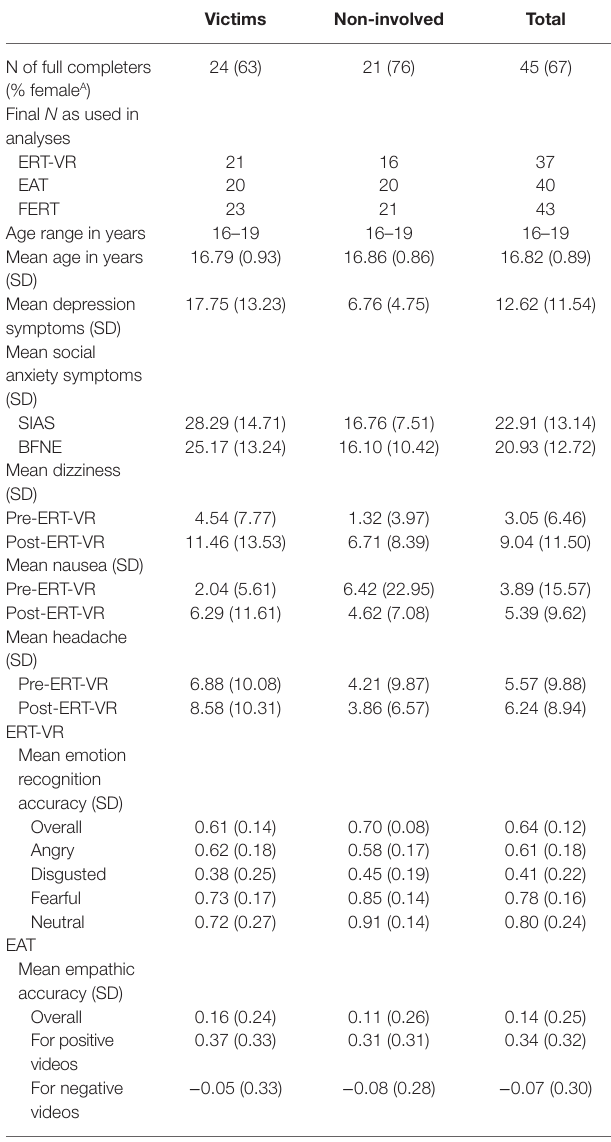
TABLE 1 | Descriptive statistics for participant characteristics, mental health, and the ERT-VR and EAT.